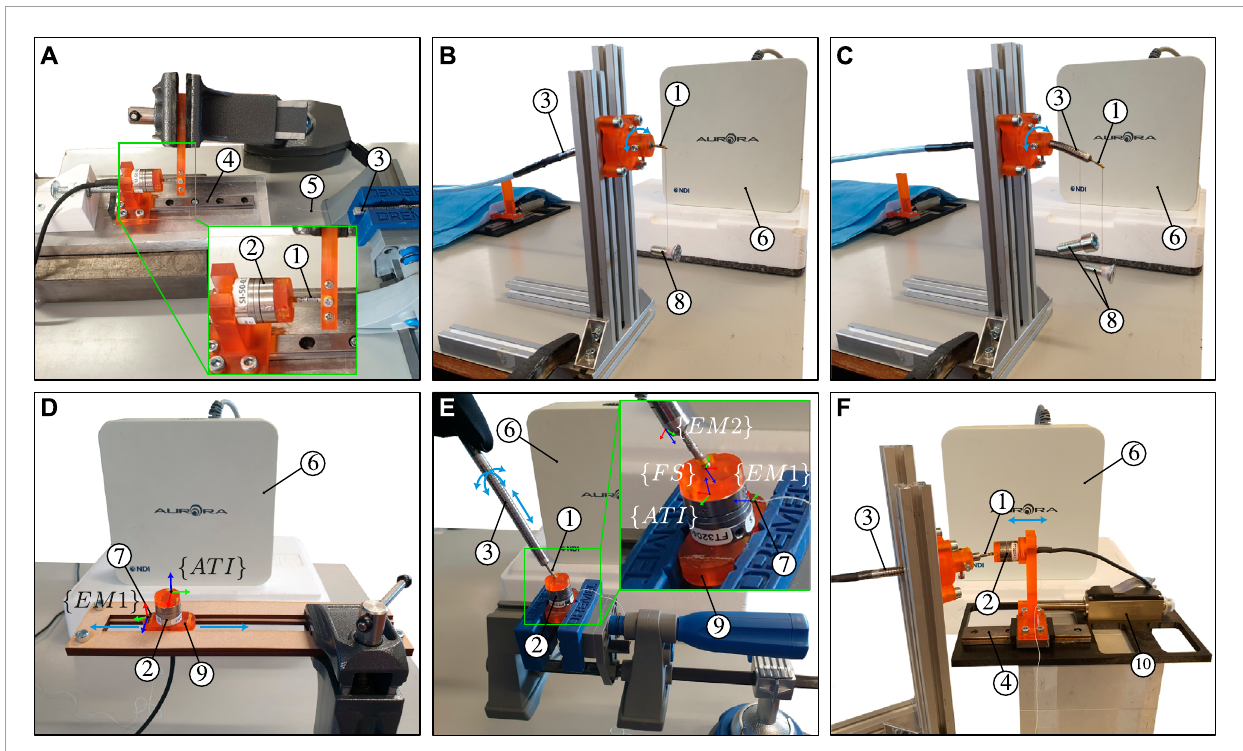
FIGURE 5 Illustration of the calibration and experimental setups for (A) MCF pre-straining through spring initial compression (B) identification of d r and θ r (C) identification of the angle between the x − axis of EM two and the first outer core of the MCF (D) identification of the angle between the x − axis of EM one and the y − axis of the ATI force sensor (E) three-dimensional catheter tip force sensor calibration, and (F) dynamic force characterization. The calibration and experimental setups contain the following elements: ① catheter tip force sensor, ② ATI Nano17 force sensor, ③ bendable and actuatable catheter, ④ linear guide, ⑤ MCF, ⑥ EM field generator, ⑦ EM two sensor, ⑧ hanging weights, ⑨ 3D printed rigid base, and ⑩ linear